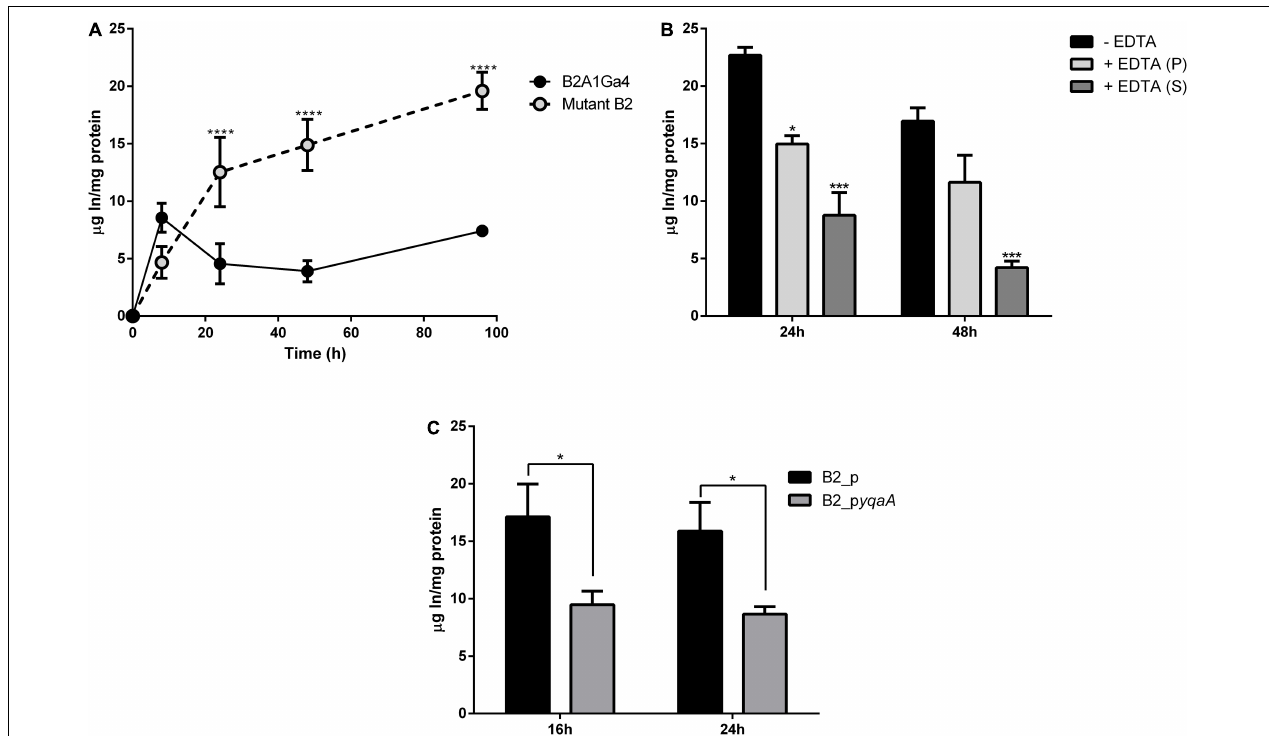
FIGURE 6 | Accumulation of In by wild strain B2A1Ga4, mutant B2, and complemented strains. Total In accumulation by native and mutant B2 strains at different times: 8, 24, 48, and 96 h (A) . In levels in different fractions of cells collected at 48 h of growth with 0.1 mM In: without EDTA treatment—total In in cells (black), cellular fraction after EDTA treatment—intracellular In (gray), and supernatant fraction after EDTA treatment—surface In complexed (white) (B) . In accumulation by strains B2_p and B2_p yqaA ( C ). Data shown are the mean values ( ± standard deviations) obtained from two independent experiments. *, ***, ****Significantly different, p < 0.05, p < 0.001, and p < 0.0001, respectively.